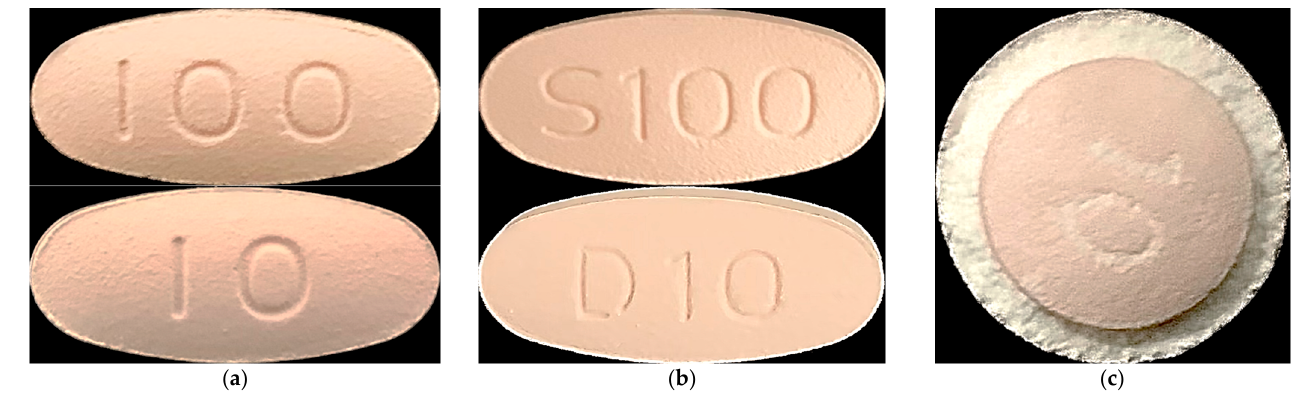
Figure 3. Morphology of three dosage forms. ( a ) Single-layer tablets, ( b ) Double-layer tablets, ( c ) Dry-coated tablets. ( c ) Dry-coated